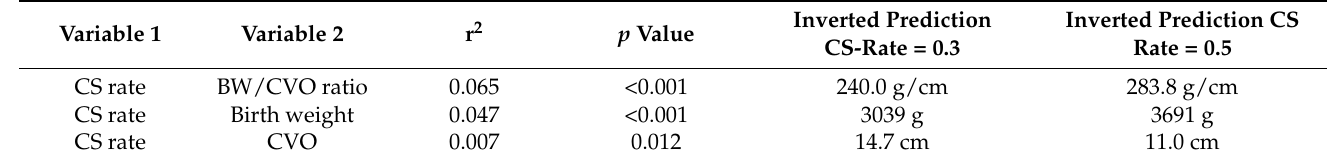
Figure 2. Linear regression of CS rate and ( A ) BW/CVO ratio, ( B ) Birth weight in gram and ( C ) CVO in cm in vaginally intended breech deliveries. Table 2. Vaginally intended deliveries ( n = 758), logistic regression analysis of CS rate.